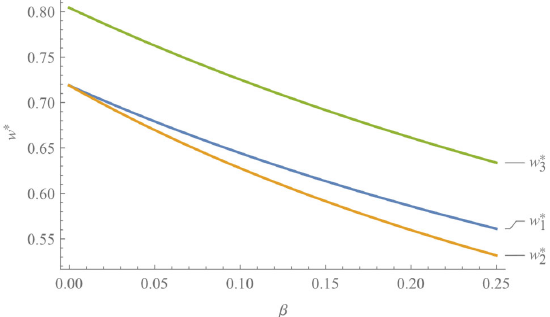
Fig. 8. The impact of the manufacturer's risk aversion on the retail